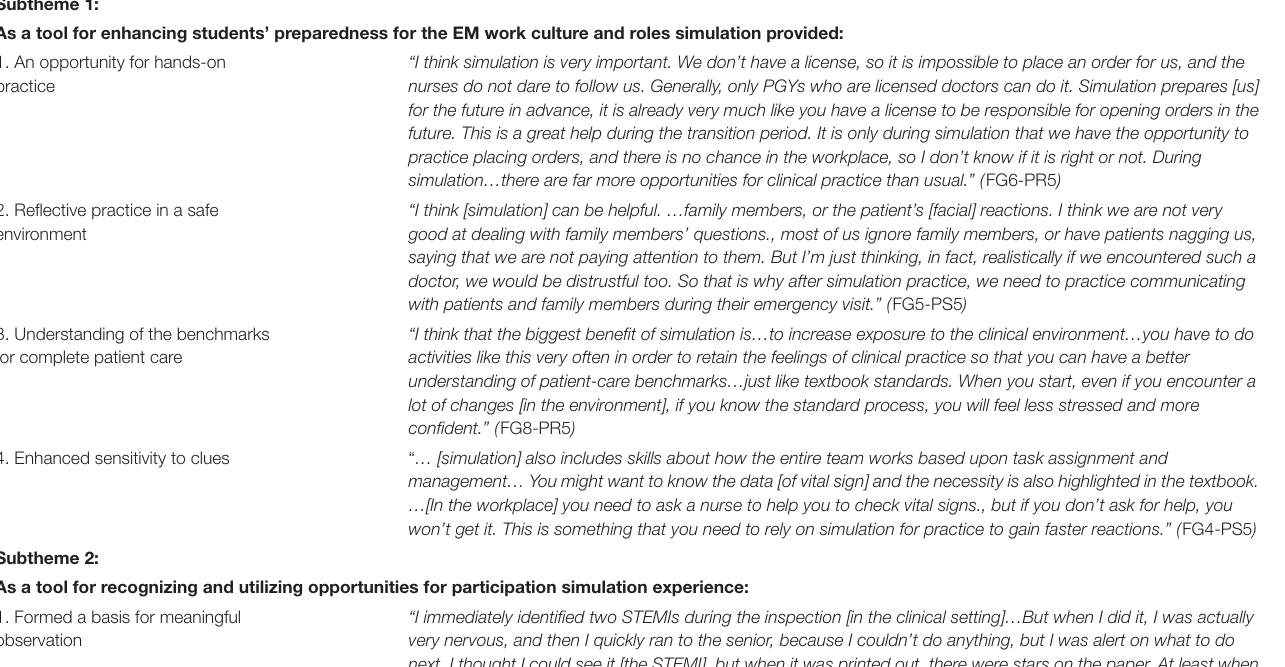
TABLE 3 | Representative quotes of theme 2—Effectiveness of the pre-course high-fidelity simulation. Subtheme